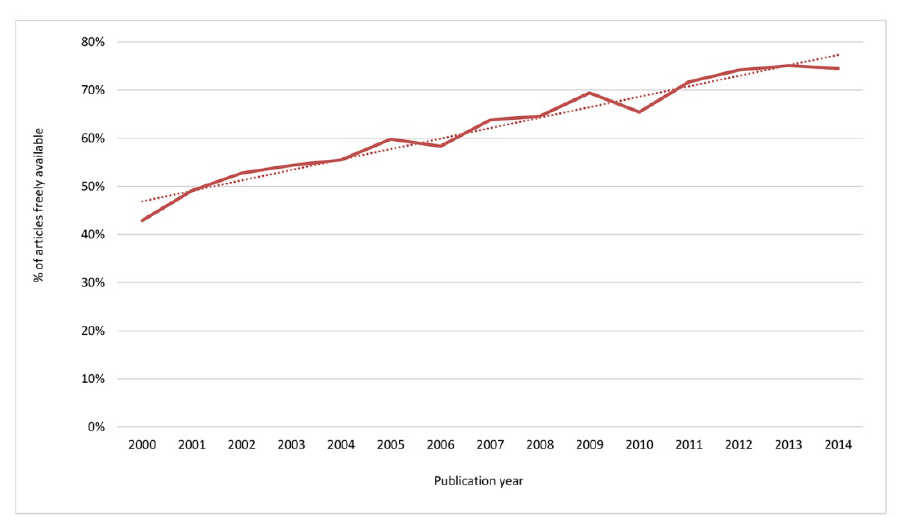
Figure 1 Trend in free, online article availability over the study period